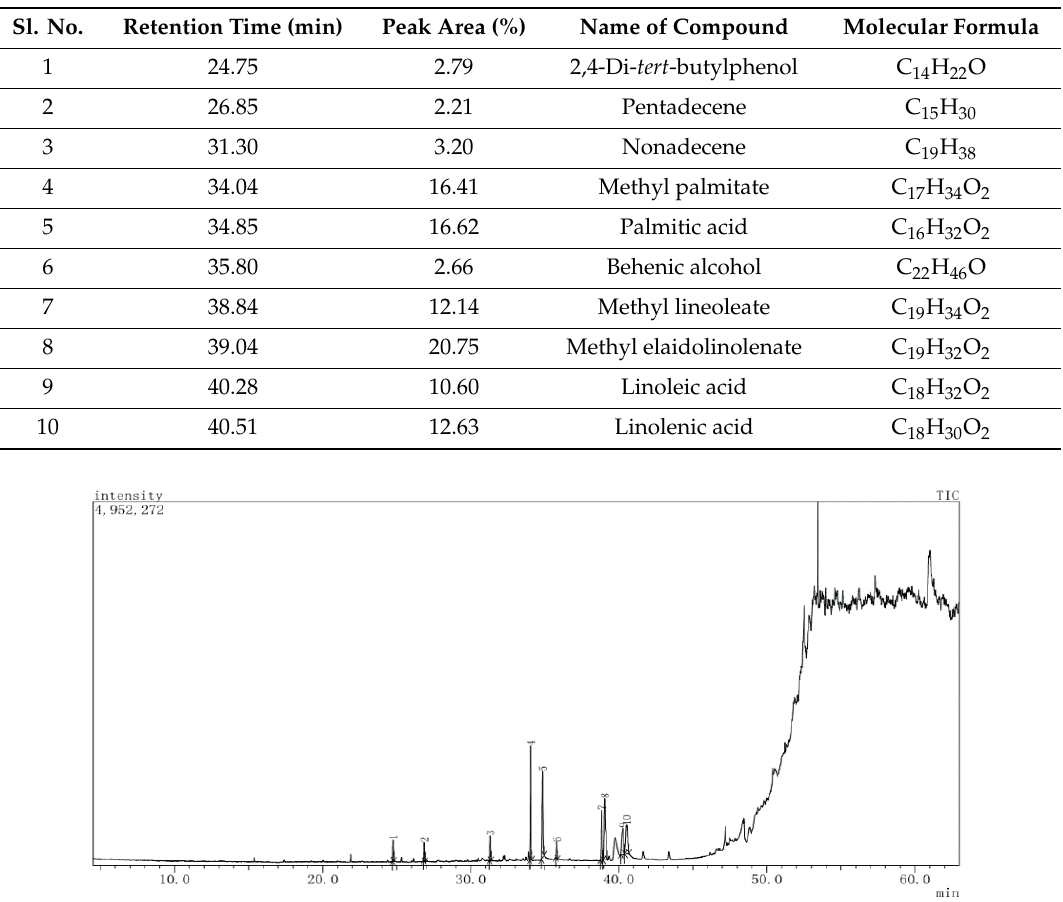
Table 1. List of chemical compounds in the dichloromethane (DTL) extract of T. leucostaphylum , identified by GC-MS.